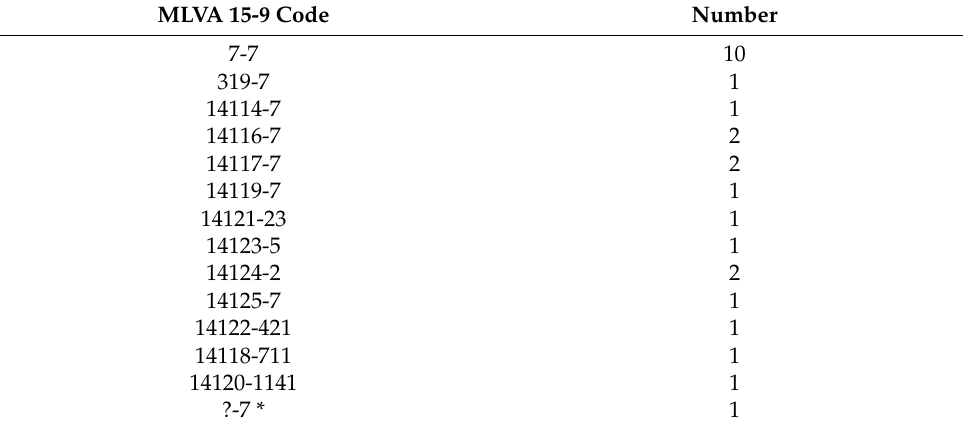
Table 4. MLVA 15-9 codes of the M. bovis